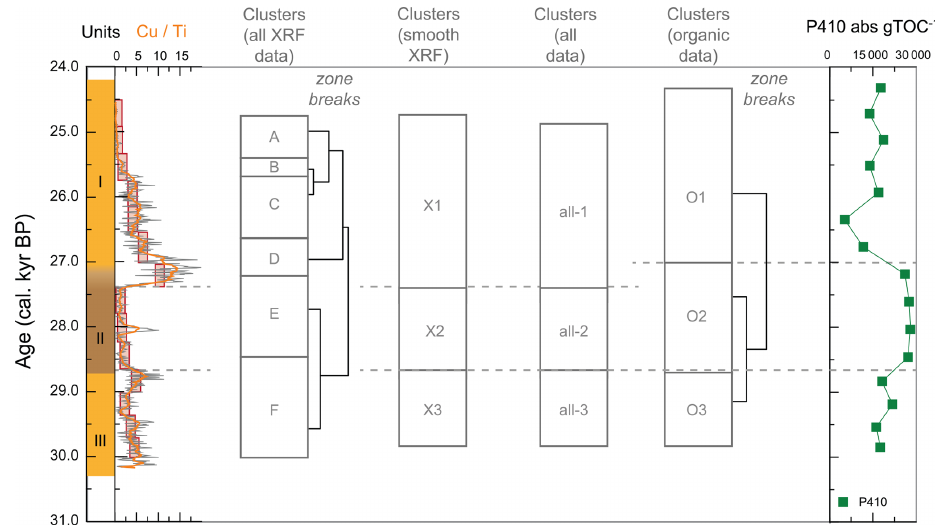
Figure A2. Comparison of cluster analysis results for original XRF data, resampled XRF data (shown in Fig. 3), and organic indicator data (shown in Fig. 4). XRF data between 0–10 and 155–160mm were removed before analysis. The left panel shows the original Cu / Ti data (grey line) with ∼ 100-year smoothing (orange line, as in Fig. 3), alongside resampled Cu / Ti data (red squares) used for cluster analysis. The right panel shows the P410 pigment absorbance signal, which may account for the offset in the O1 / O2 cluster boundary compared to 1 / 2 boundary in other